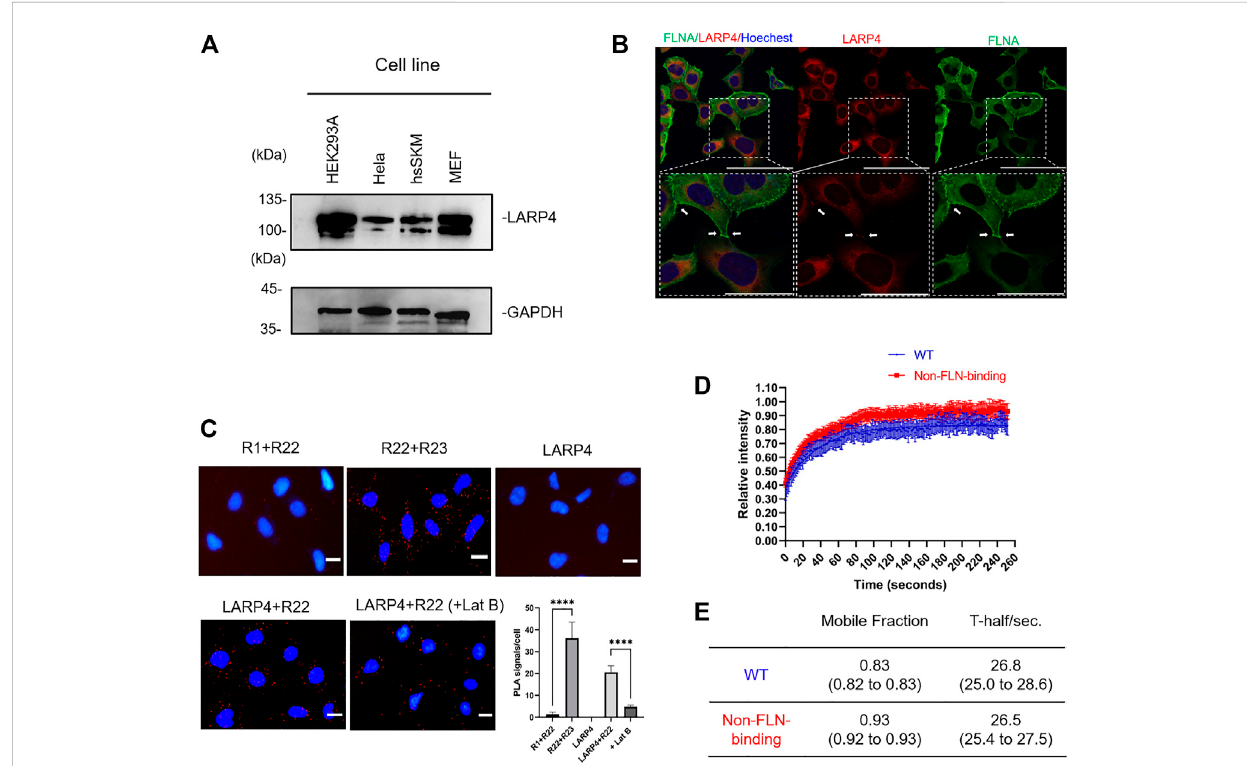
FIGURE 6 InteractionofLARP4withFLNAinlivingcells. (A) Approximately1.2×10 6 HEK293A,Hela,hsSKM,andMEFcells cellswereanalyzedbyWBusinganti-LARP4 antibodies. The lower band is the indicative of the degradation of LARP4 protein. GAPDH is used as a loading control. (B) Co-localization of LARP4 and FLNA in HEK293A (Bar: 100 μ m). Enlarged images are shown in the dotted box in white. Bar: 50 μ m. White arrows indicate the cell-cell junction. (C) Interactions of LARP4 with FLNA R22 in HEK293A cells visualized by proximity ligation assay (PLA). Representative PLA images where the PLA signal (red) represents close proximity ( < 40 nm) between two proteins. PLA signal is signi fi cantly decreased when cells are treated with 5 μ M Latrunculin B for 1 h. Graph shows the quanti fi cationofPLAbetweenFLNAR1andR22,R22andR23,LARP4,LARP4andR22andunderLatBtreatmentrespectively( n =5).Thenucleuswasstainedby Hoechst(blue).Scalebarsare20 μ m**** p < 0.0001wasdeterminedbythetwo-tailedunpairedStudent ’ stest. (D) FRAPanalysiswasperformedinHEK293Acells transfected GFP-LARP4 WT or GFP-LARP4 F277A. Quantitative analyses of FRAP assay results. Curves depict mean values (±SD) from measurements of at least 6representativecells(n ≥ 10).WT(blue),non-FLN-bindingF277A(red). (E) F max